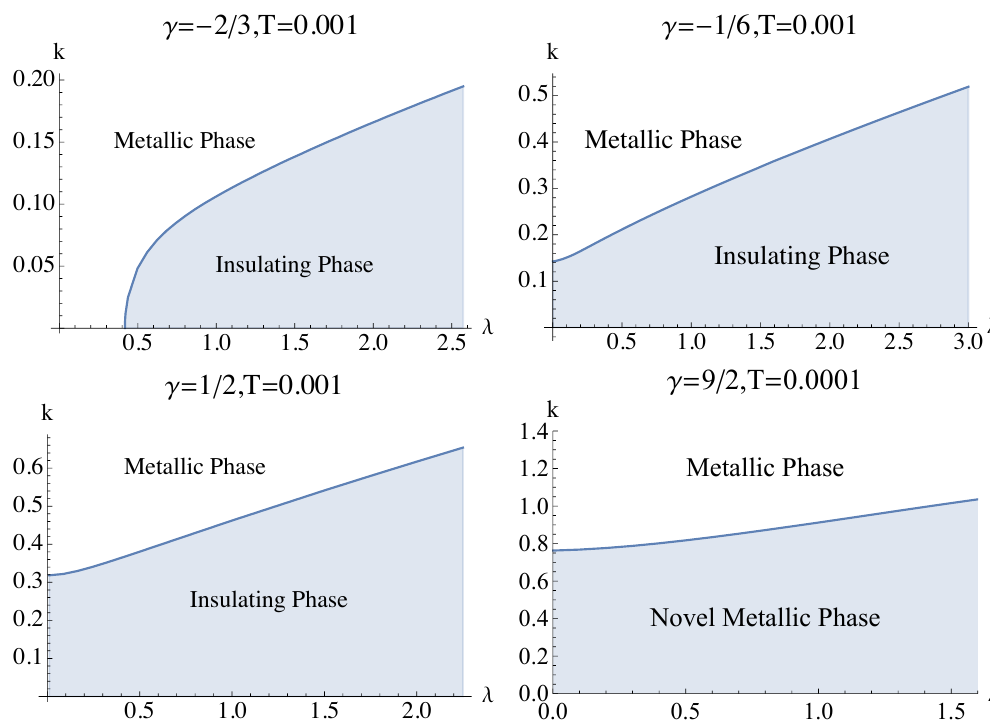
Figure 1 . The phase diagram over the { λ, k } with different γ at some fixed temperatures. The blue line is the critical line of the phase